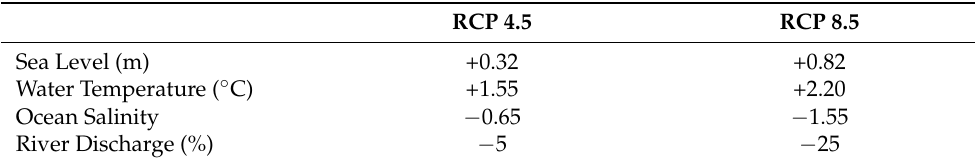
Table 1. Changes at the ocean and river boundary inputs applied in the simulations of future scenarios.